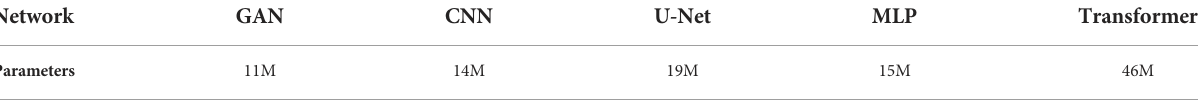
TABLE 7 Parameters of the networks used for deformable image registration. Network